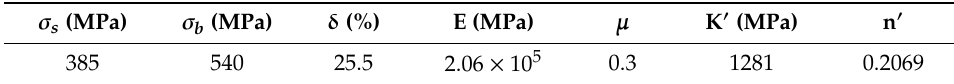
Figure 5. Cruciform welded joint: ( a ) Geometry of the specimen (mm); ( b ) 3D model of the specimen. Table 1. Basic mechanical parameters of the specimen.